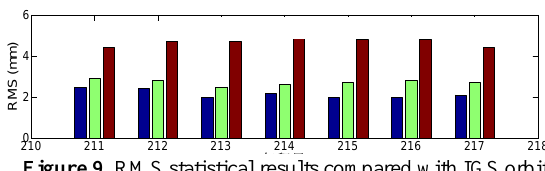
Figure 9 . RMS statistical results compared with IGS